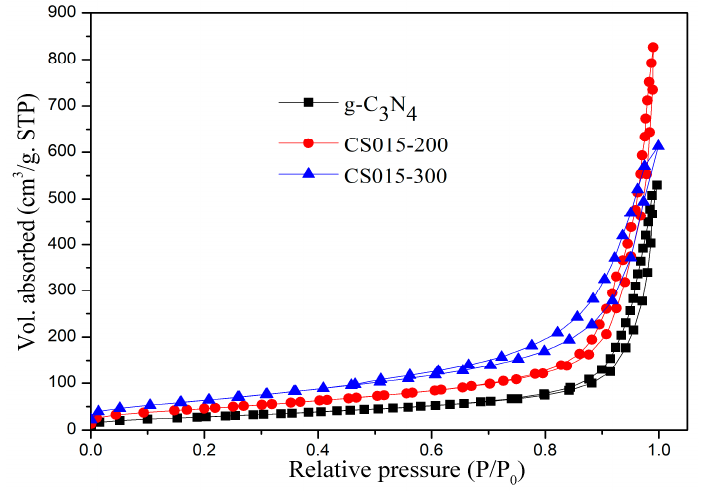
Figure 5. N 2 adsorption-desorption isotherms of g-C 3 N 4 , CS015-200, and CS015-300.